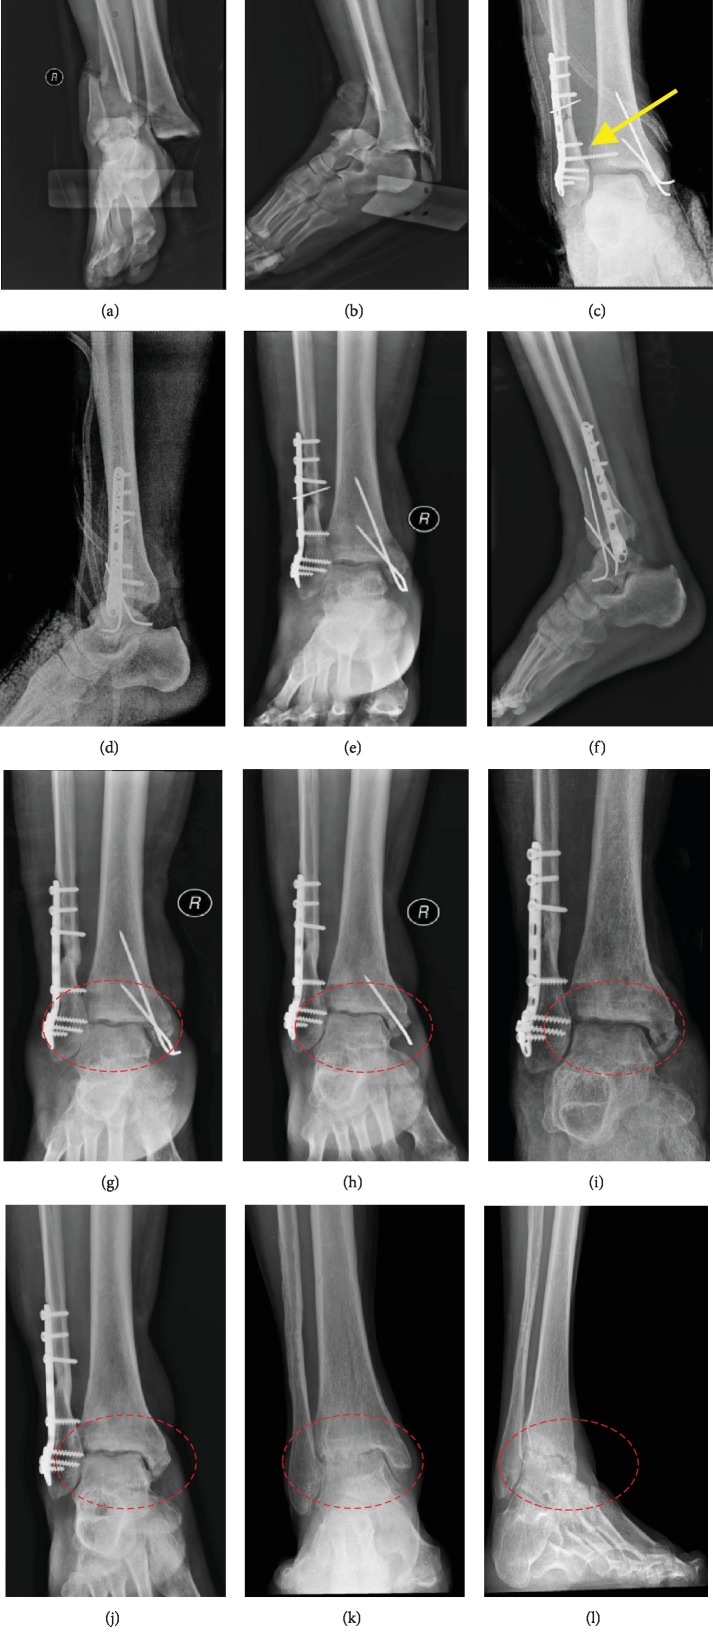
Preoperation (a, b) and postoperation radiographs after first reduction and debridement (c, d) from a 37-year-old man who suffered from falling from a height, showing the malreduction of the lower tibiofibular joint (yellow arrow). Thus, we performed revised surgery (e, f) to obtain acceptable anatomy of TFOL and TFCS. However, gradual degeneration of the tibiotalar joint and deterioration of the joint surface were observed along with the different follow-up (red circle with dot line) (g–j). Finally, significant posttraumatic osteoarthritis occurred at the ankle joint at the last follow-up (k, l).